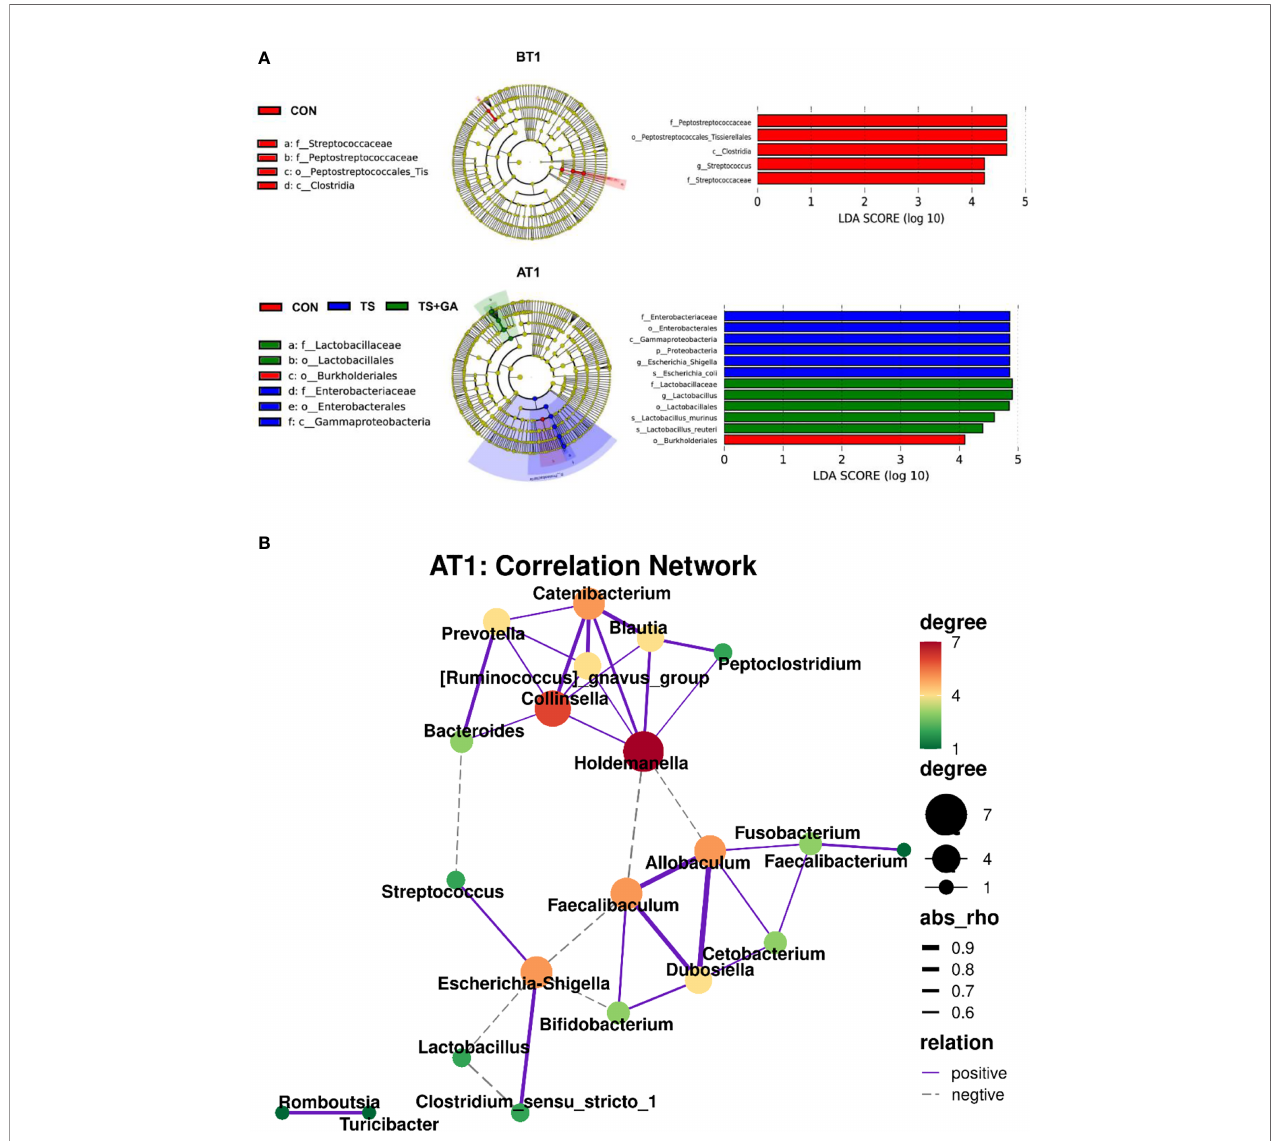
FIGURE 4 | The linear discriminant analysis effect size (LEfSe) analysis identi fi ed gut bacterial biomarkers in puppies on BT1 and AT1 (A) . Spearman ’ s correlation network of fecal microbiota at genus level on AT1 (purple solid line, positive correlation; gray dotted line, negative correlation; thick line, signi fi cant correlation, p < 0.05) (B) . BT1, the 1st day before transportation; AT1, the 1st day after